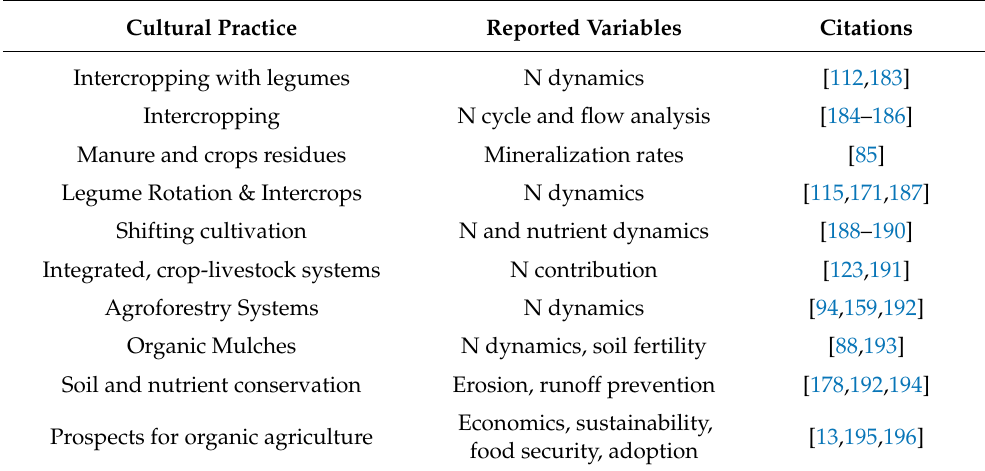
Table 4. A sample of studies and adoption of nitrogen management practices under subsistence agriculture 1